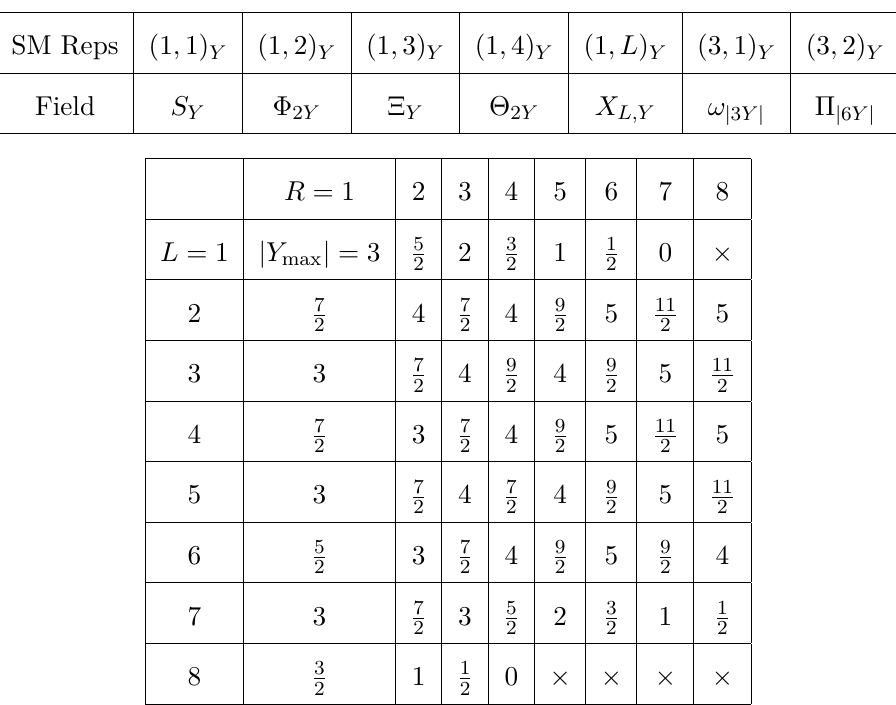
Table 1 . The representations and corresponding fields for the scalar BSM Loryons considered in this work. We express “SM charges” as ( C, L ) and “custodial charges” as [ L, R ] ; the custodial Y Y representation [ L, R ] contains SM fields ( C, L ) to ( C, L ) in steps of unit Y − ( R − 1) / 2+ Y ( R − 1) / 2+ Y hypercharge. Hypercharges Y are restricted so that any new charged particles can promptly